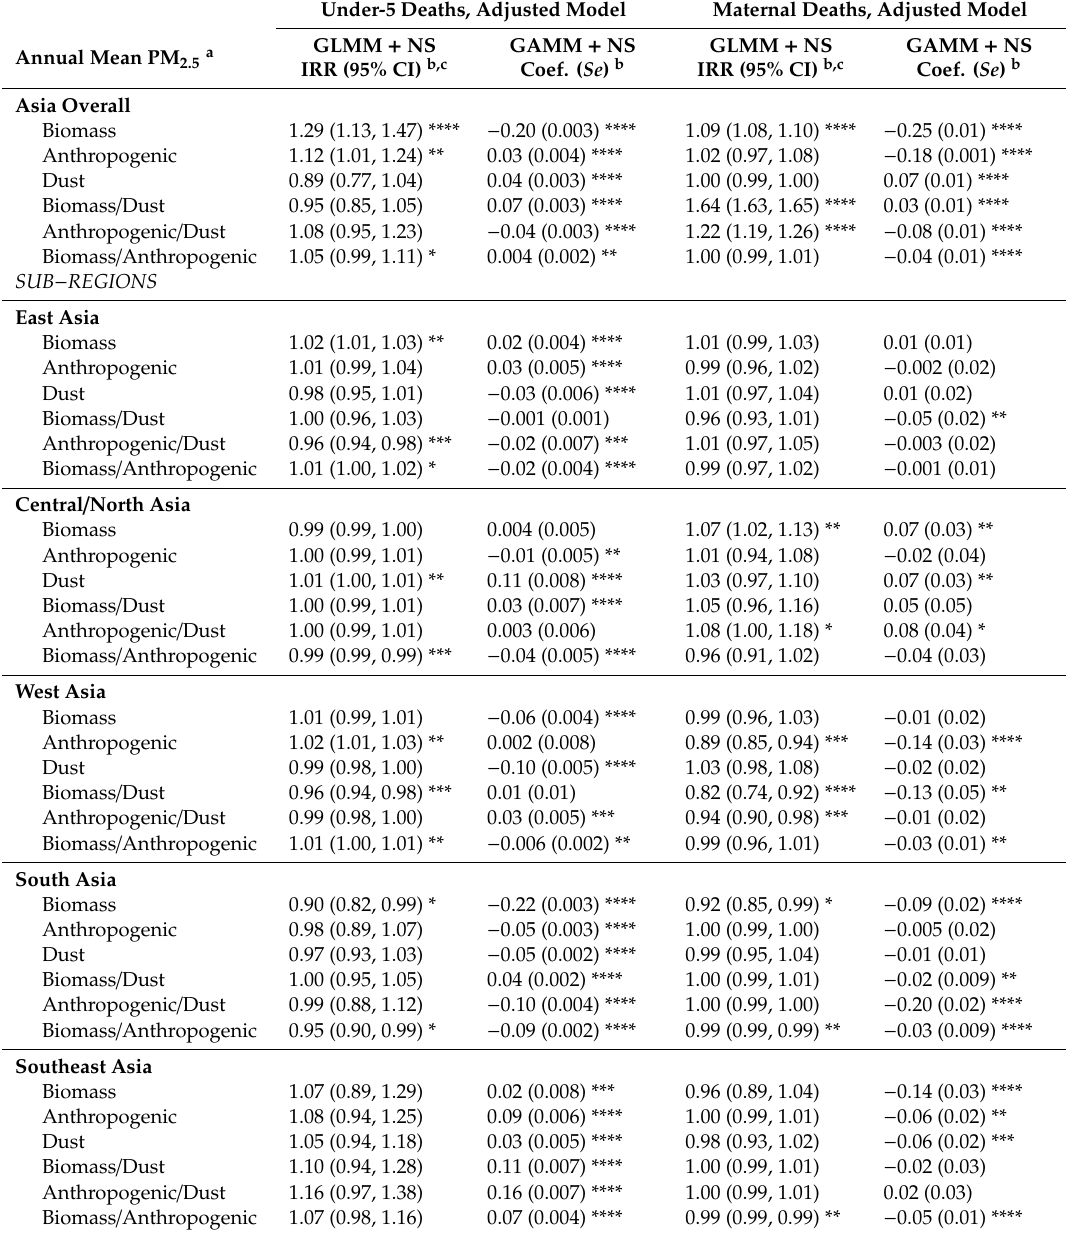
Table 3. Adjusted generalized linear mixed-e ff ect models and generalized additive mixed-e ff ect models of under-5 and maternal mortality by sub-regions of